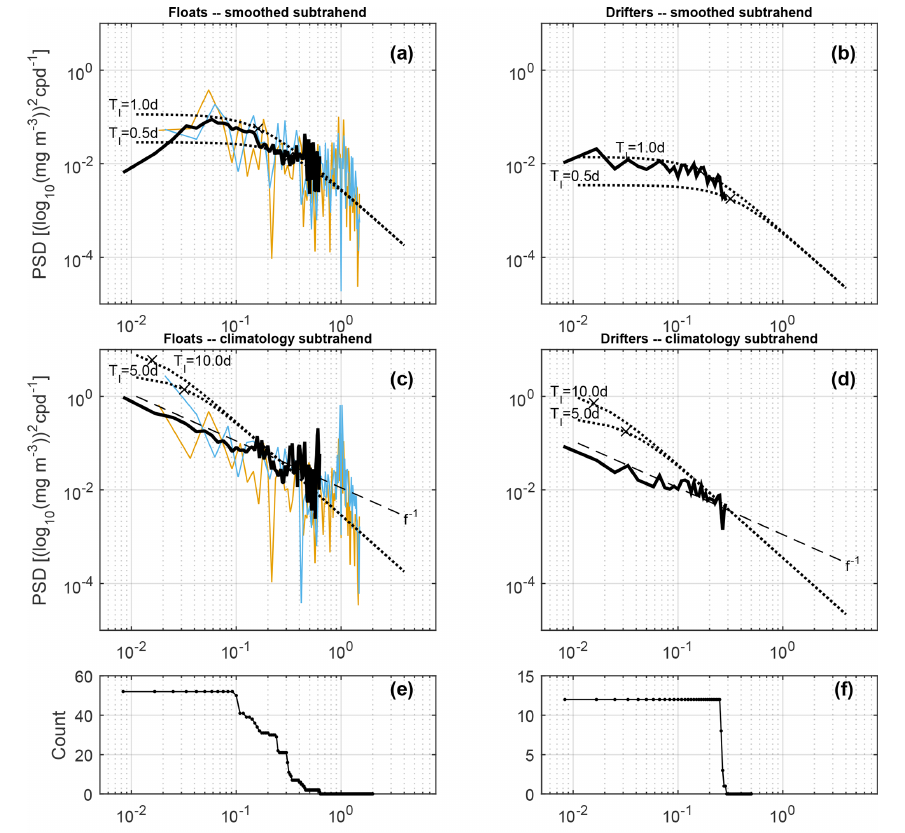
Figure 8. Averaged Lomb spectra for chlorophyll from all valid float (a, c, e) and drifter (b, d, f) segments, as defined in Sect. 3.6. Spectra in panels (a) and (b) and panels (c) and (d) are calculated from Chl anomalies relative to the smoothed and climatological subtrahend respectively. Panels (e) and (f) give counts of valid estimates per frequency. For float spectra, the bold black line is the space-averaged spectrum, while the orange (blue) spectrum is from the individual metbio003d (metbio010d) segment. Dotted reference spectra are theoretical spectra for an exponential autocorrelation function (ACF) with a decorrelation time T l , Chl as labelled. Dashed spectra in panels (c) and (d) give a − 1 power law